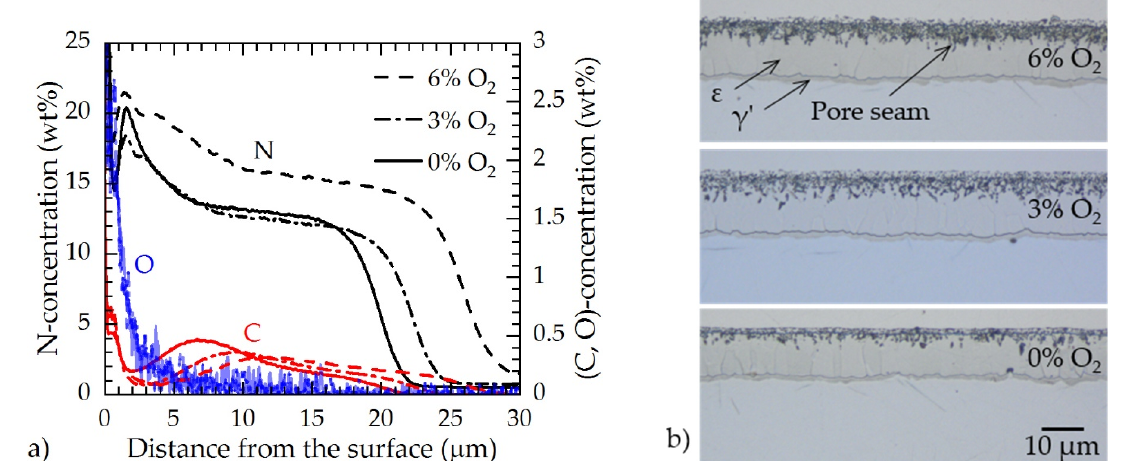
Figure 4. ( a ) Element concentration-depth profiles of nitrogen, carbon, and oxygen of the ARMCO ® iron samples treated